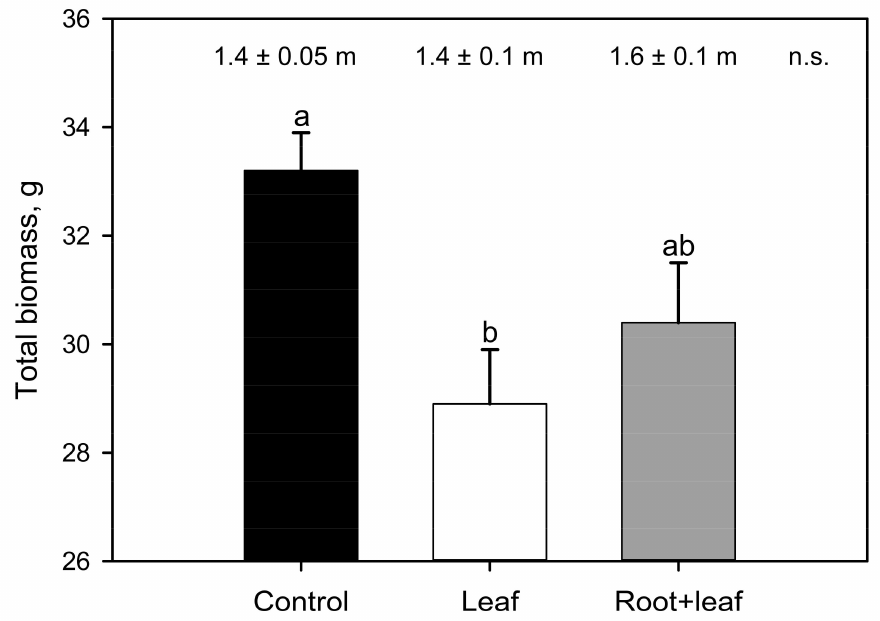
Figure 2. Total plant biomass (histogram) and absolute shoot length (top part) as measured in control (C, black bar), leaf infested (L, white bar), and both root and leaf infested (R + L, grey bar) plants 56 days after inoculation. Different letters indicate significant differences among groups (one-way ANOVA); n.s. indicates lack of significant